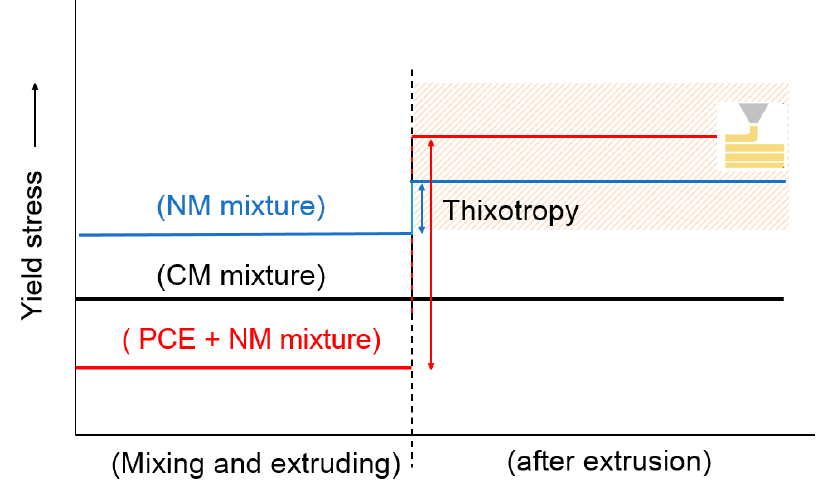
Figure 7. Schematic of rheology modification for 3D concrete printing.